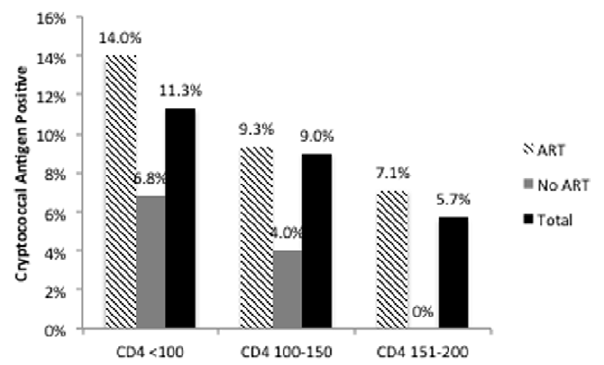
Figure 1. Percentage of HIV infected patients with cryptococcal antigenemia by CD4 count and antiretroviral use.